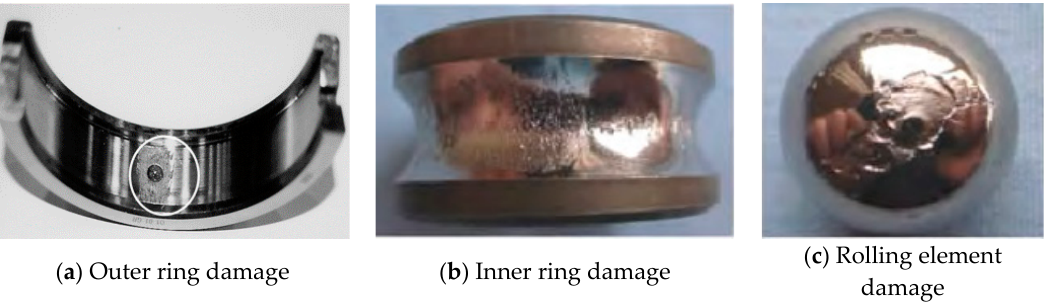
Figure 6. Test stand for collecting vibration signals from REBs used by CWRU.